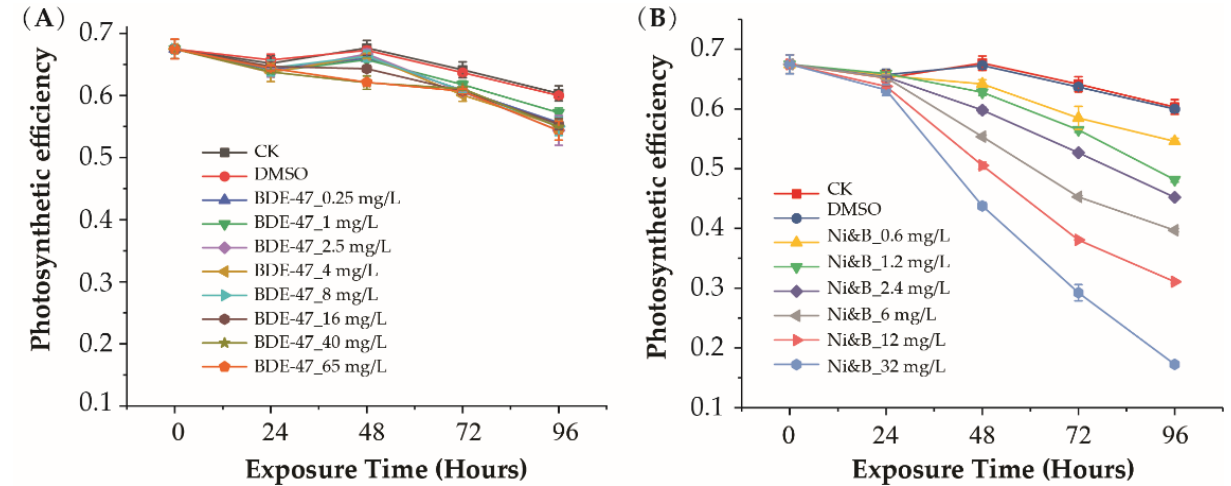
Figure 2. Photosynthetic efficiency of P. tricornutum after individual BDE-47 treatment ( A ) and treatment with mixtures of BDE-47/nickel ( B ). Error bars indicate ± SD. p -values are shown in Table S4.